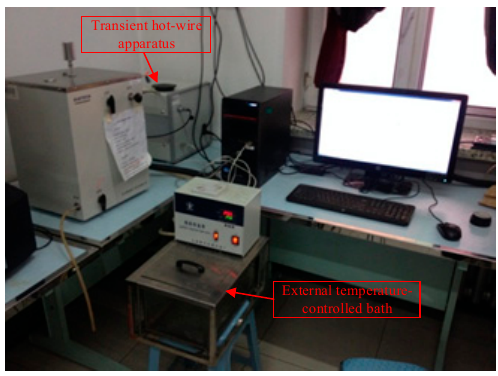
Figure 3. Measuring equipment of thermal conductivity for Al 2 O 3 -water nanofluids.